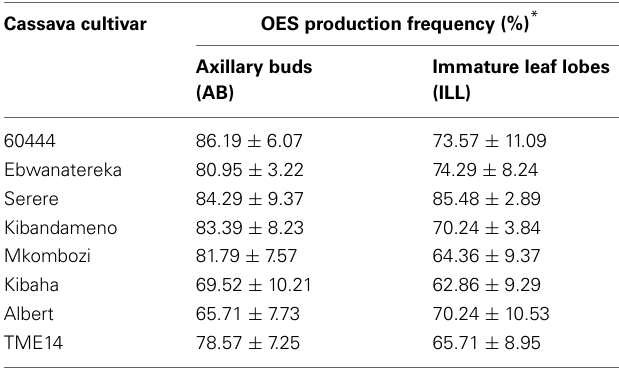
Table 2 | Average frequencies of somatic embryos induced from different explants of various cassava